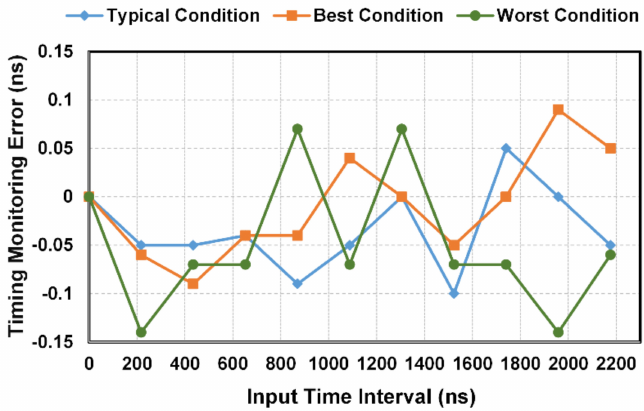
Figure 10. Timing measurement errors under three operation